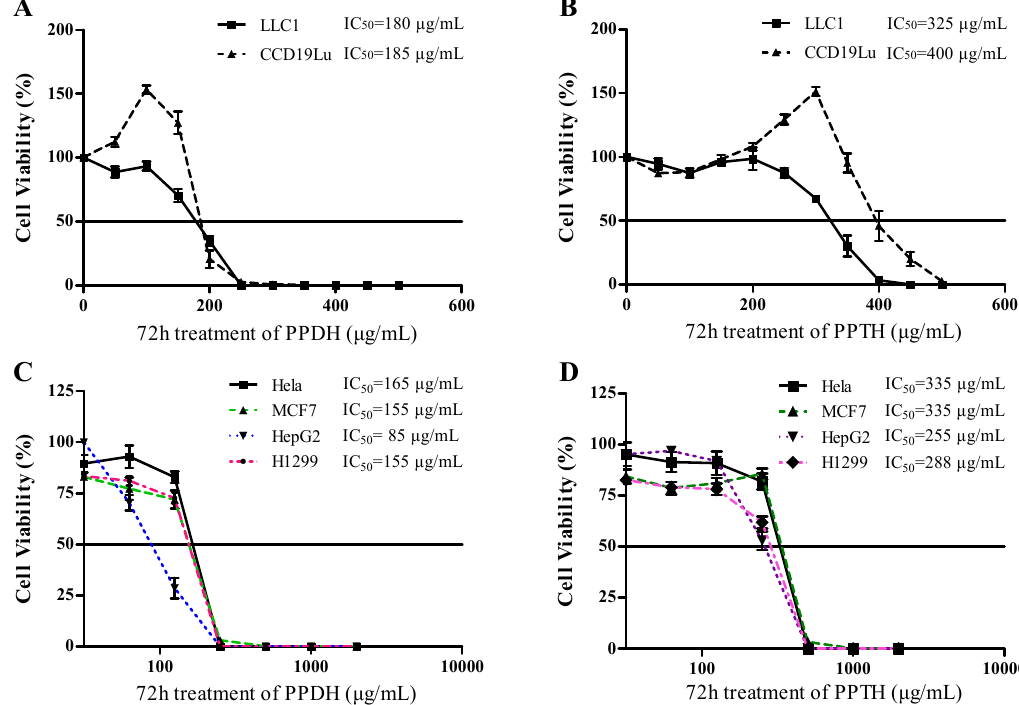
Figure 6. Effect of PPDH or PPTH ginsenosides on inhibition of cell growth of the lung normal fibroblast cell line CCD19Lu and cancerous cell